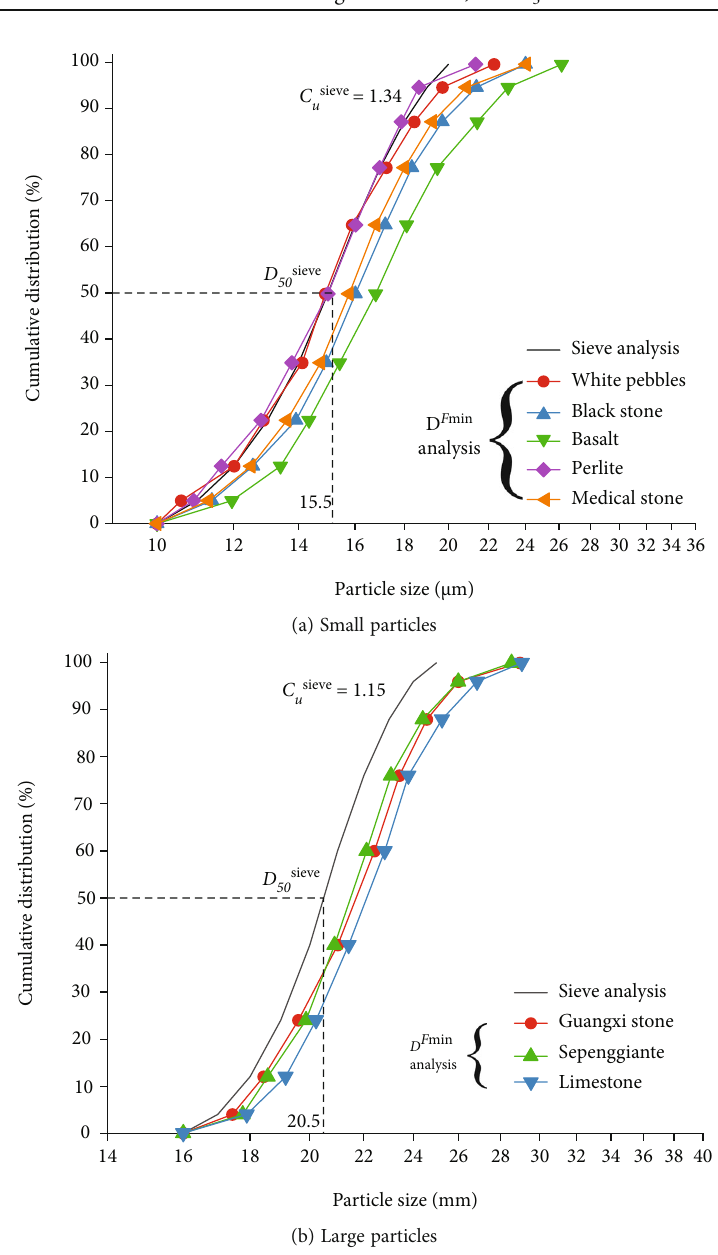
Figure 2: Particle size cumulative distribution for sieve analysis and D F min